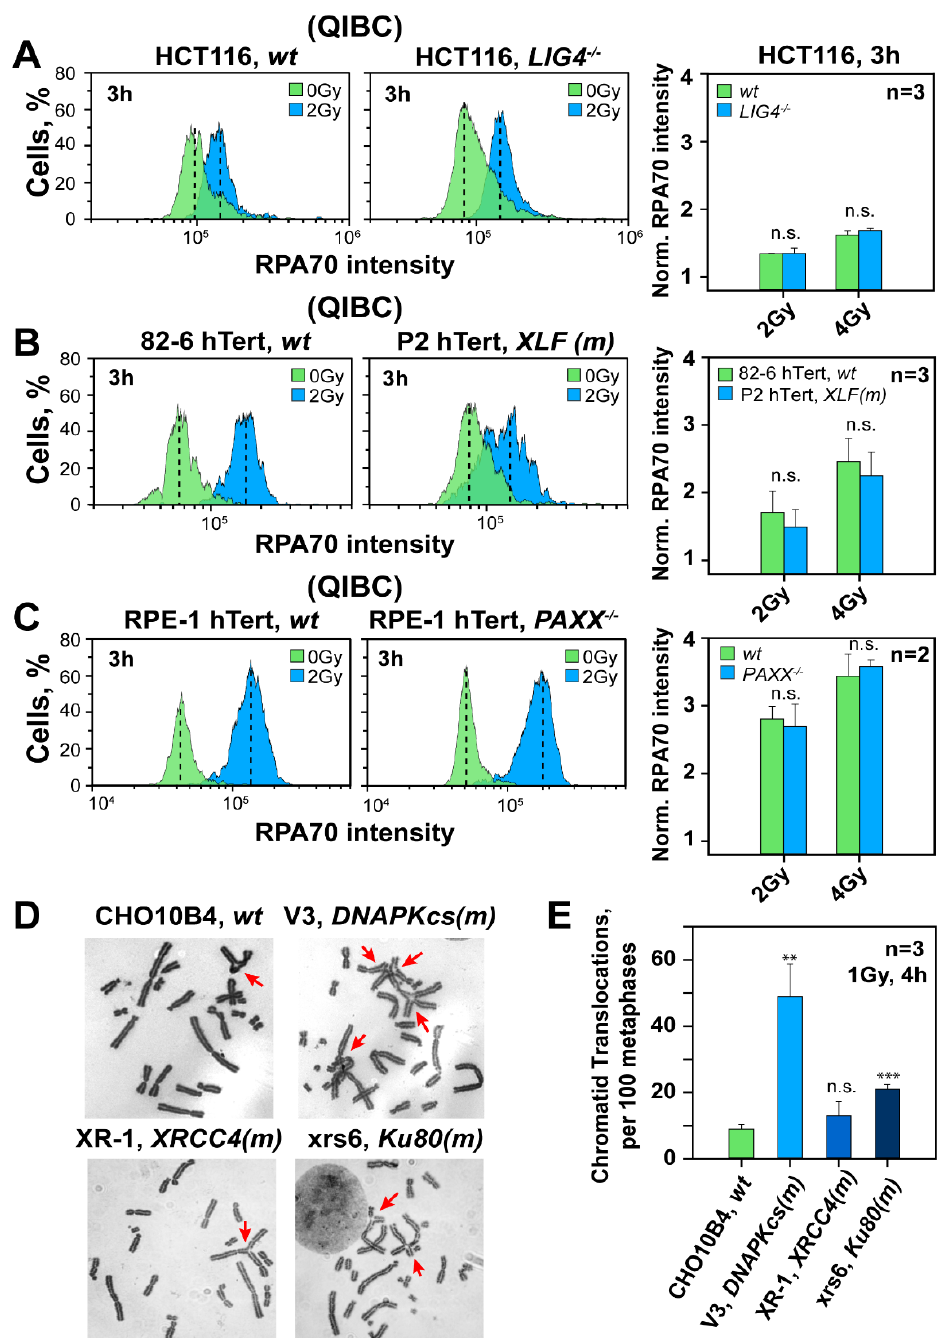
Figure 4. Deficiency in c-NHEJ factors other than DNA-PKcs leaves unchanged resection in G 2 - phase, but DNA-PKcs deficiency dramatically increases translocations. ( A ) QIBC analysis of RPA70 in parental and LIG4 -/- HCT116 human cells in G2-phase. Bar plots on the right represent the normalized RPA70 signal intensity from three experiments. ( B ) As in panel A for 82-6 hTert and the P2 hTert fibroblast cell line with a defect in XLF . ( C ) As in panel A, for RPE-1 hTert cells and a derivative PAXX -/- cell line. ( D ) Representative metaphase spreads of CHO10B4, V3, XR-1 and xrs6 cells depicting chromatid translocations at 4 h post 1 Gy IR. Translocations are marked with arrows ( E ) Frequency of IR induced translocations in wt CHO10B4 and c-NHEJ mutants (V3, XR-1 and xrs6 cell lines) at 4 h post 1 Gy IR. The mean ± SD shown represent data from three independent experiments. ** indicates p < 0.01 and *** indicates p < 0.001, while n.s. indicates non-significance.